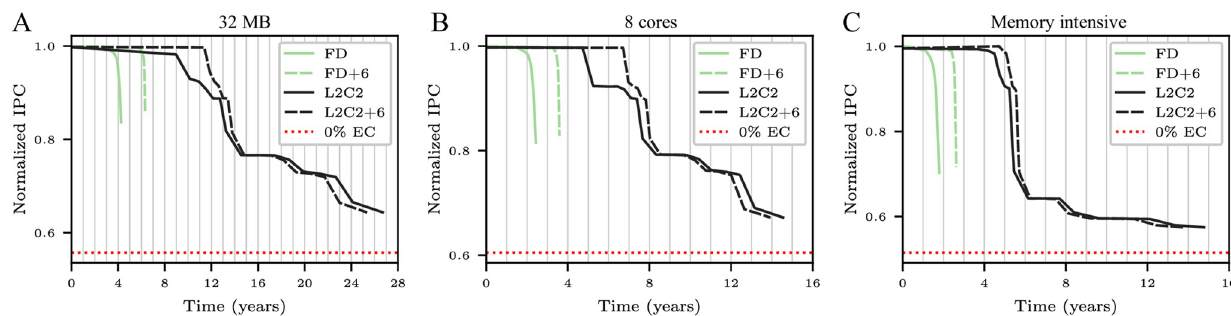
Fig 15. IPC evolution until losing 50% of capacity of FD and L2C2 for cv = 0.2. Doubling cache size (A), doubling the number of cores while keeping the same 4MB/core (B), and only considering the most memory-intensive programs (C).